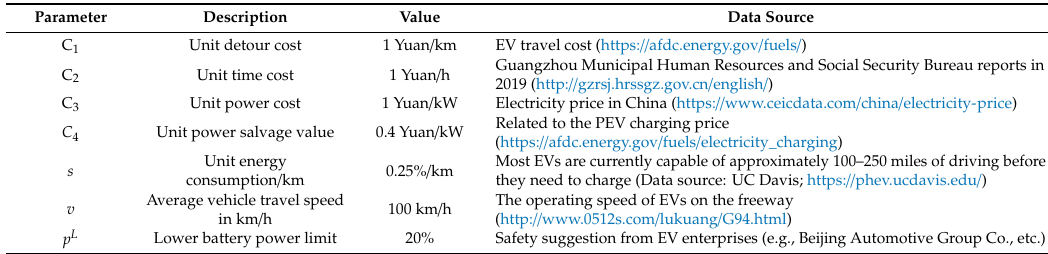
Table 5. Default parameter settings.